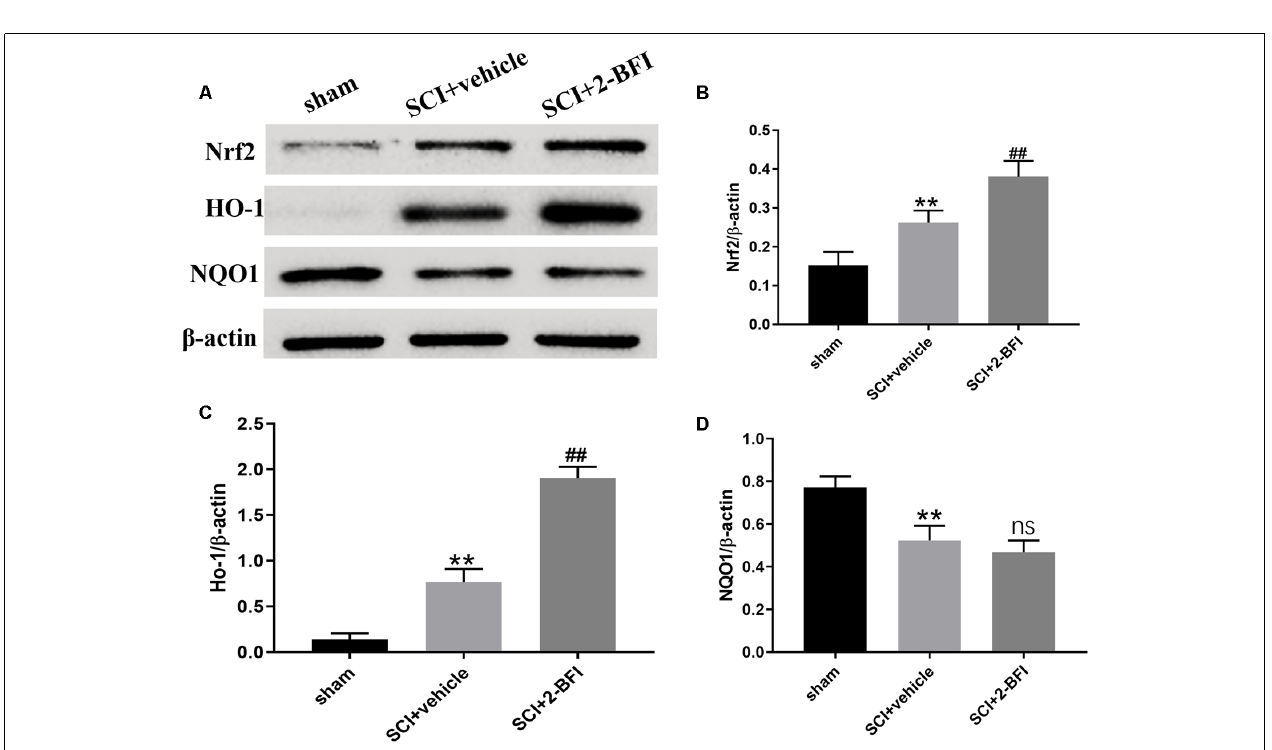
FIGURE 3 | Expression profiles of the Nrf2, HO-1 and NQO1 proteins in the spinal cord tissue surrounding the damage of each group at 3 days after SCI (A) . Western blotting was performed to determine the expression profiles and quantification results of Nrf2 (B) , HO-1 (C) and NQO1 (D) . Band density was quantified using ImageJ. n = 6 animals per group. Columns represent the mean ± SD. ∗∗ P < 0.01 vs. the sham group; ## P < 0.01 vs. the SCI+vehicle group; ns, no significance vs. the SCI+vehicle group.